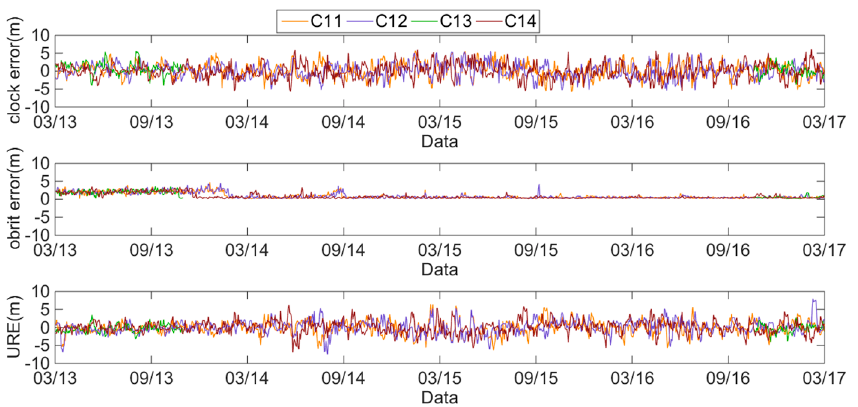
Figure 4. Errors of IGSO satellites from March 1, 2013 to March 1, 2017.